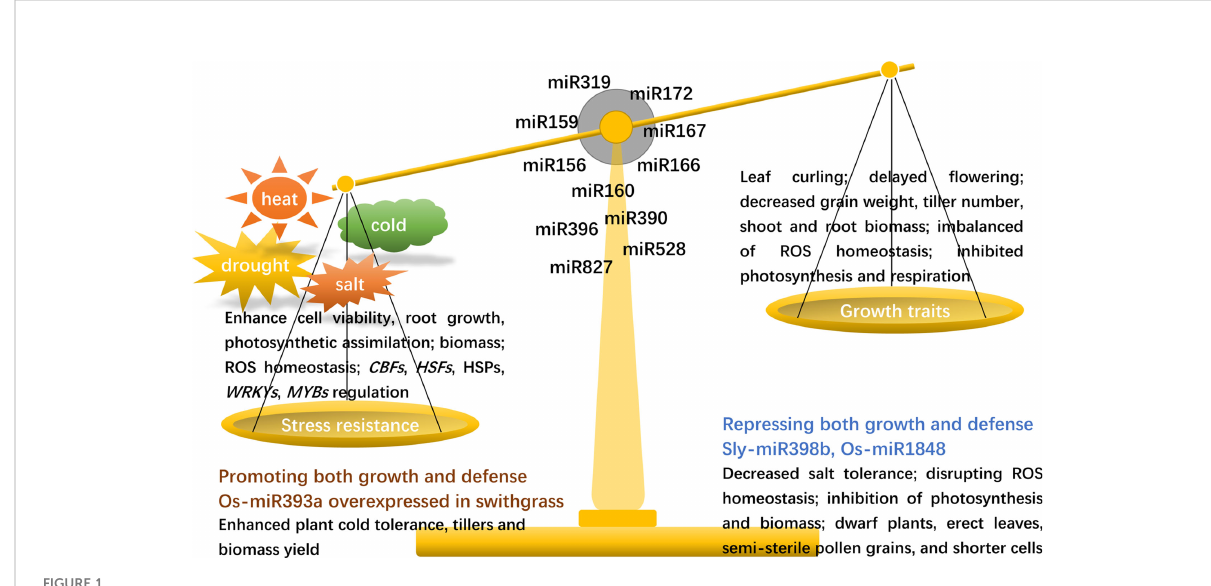
FIGURE 1 A diagram of miRNAs in regulating the trade-off between plant growth and development versus abiotic stress resistance. While improving plant abiotic resistance, miRNAs usually inhibit plant growth and development, affect plant morphological structure, suppress photosynthesis and respiration, disrupt ROS balance, and fi nally reduce crop yield. The interesting cases are that Os-miR393a promotes both growth and stress resistance while Sly-miR398b and Os-miR1848 repress growth and stress resistance. ROS, reactive oxygen species; CBFs , C-REPEAT BINDING FACTORS ; HSFs , HEAT STRESS TRANSCRIPTION FACTORS ; HSPs, heat shock proteins; MYBs, MYOBLASTOSIS